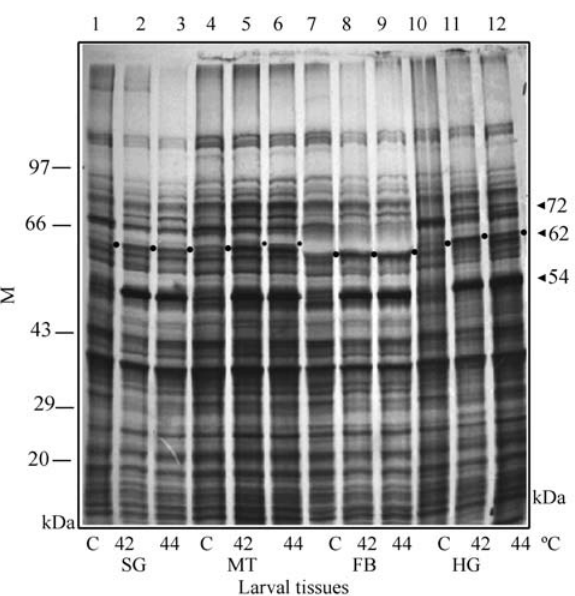
Figure 1A - Autoradiograph showing the expression patterns of the 62 kDa (HSP60) and 72 kDa (HSP70) proteins in 25 °C control (C) and 42 °C and 44 °C heat shocked salivary gland (SG), Malpighian tubule (MT), fat body (FB) and hindgut (HG) tissues of larval M. domestica (N = 15)